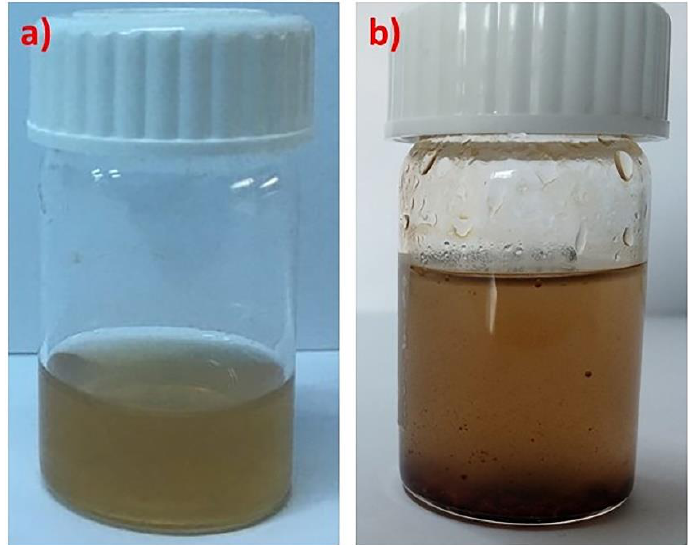
Figure 1. Colloidally stable ( a ) and unstable ( b ) mixed solutions of PLMA 22 - b -POEGMA 32 micelles containing 10 and 20 wt % of magnetic nanoparticles (NPs) relative to PLMA, respectively.